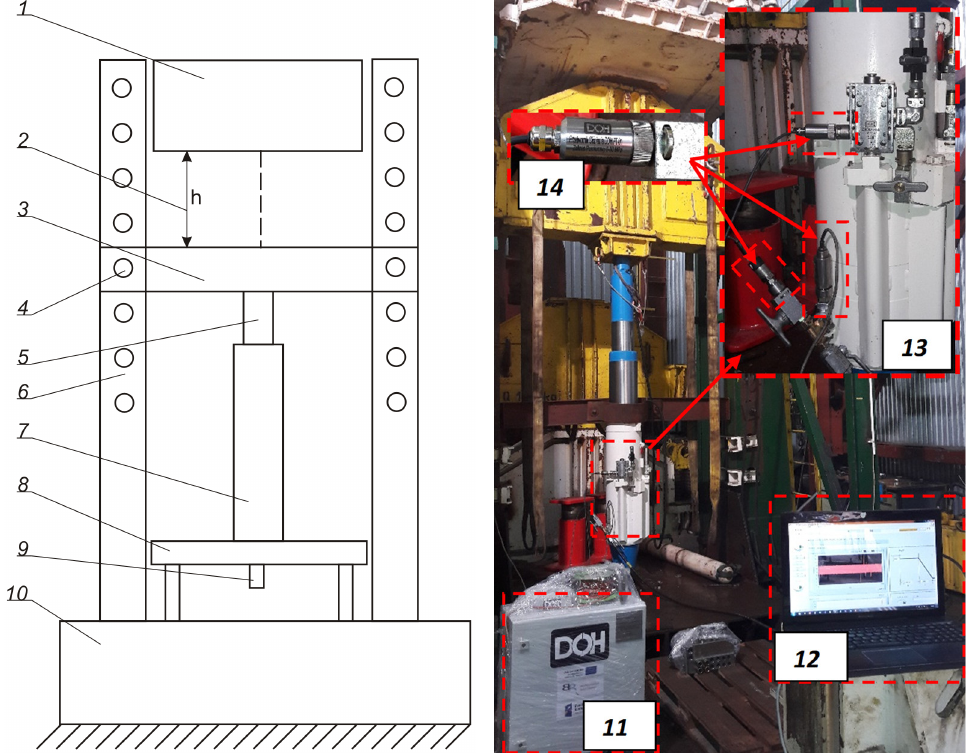
Figure 5. Scheme of the testing station, where: 1—impact mass 20,000 kg, 2—slope height, 3—traverse 3300 kg, 4—crosshead locking pin in the stand frame, 5—hydraulic piston rod, 6—impact mass slides, 7—hydraulic stand cylinder with pressure sensor, 8—basis of the position, 9—the valve to be tested fixed in the bottom of the leg cylinder, 10—foundation of the position, 11—innovative measuring and recording system, 12—computer PC, 13—hydraulic system under test, 14—pressure sensor.